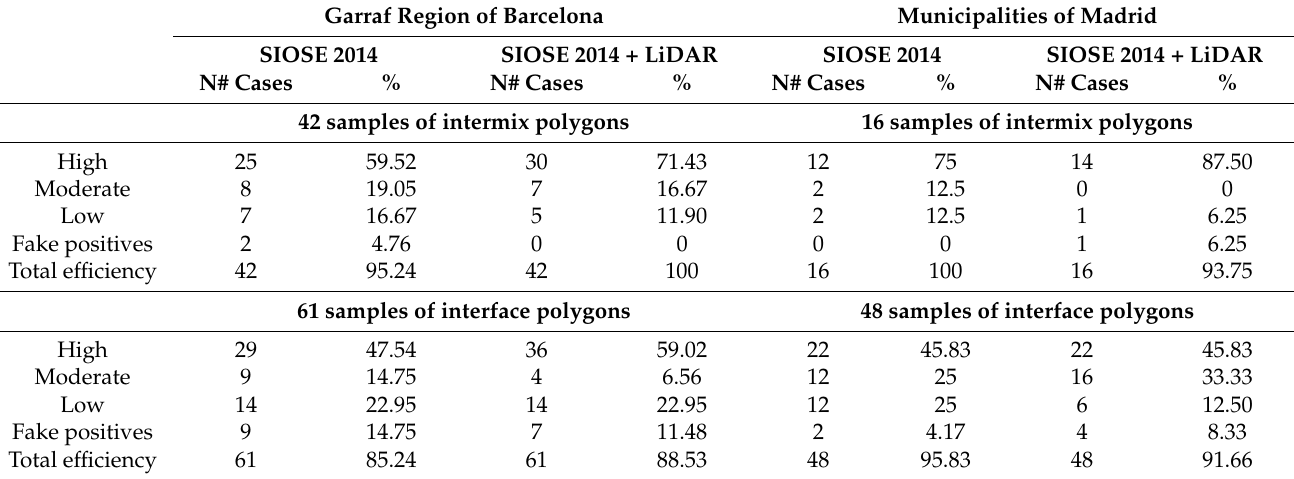
Table 4. Comparison of exposure between intermix and interface from SIOSE and SIOSE + LiDAR. Garraf Region of